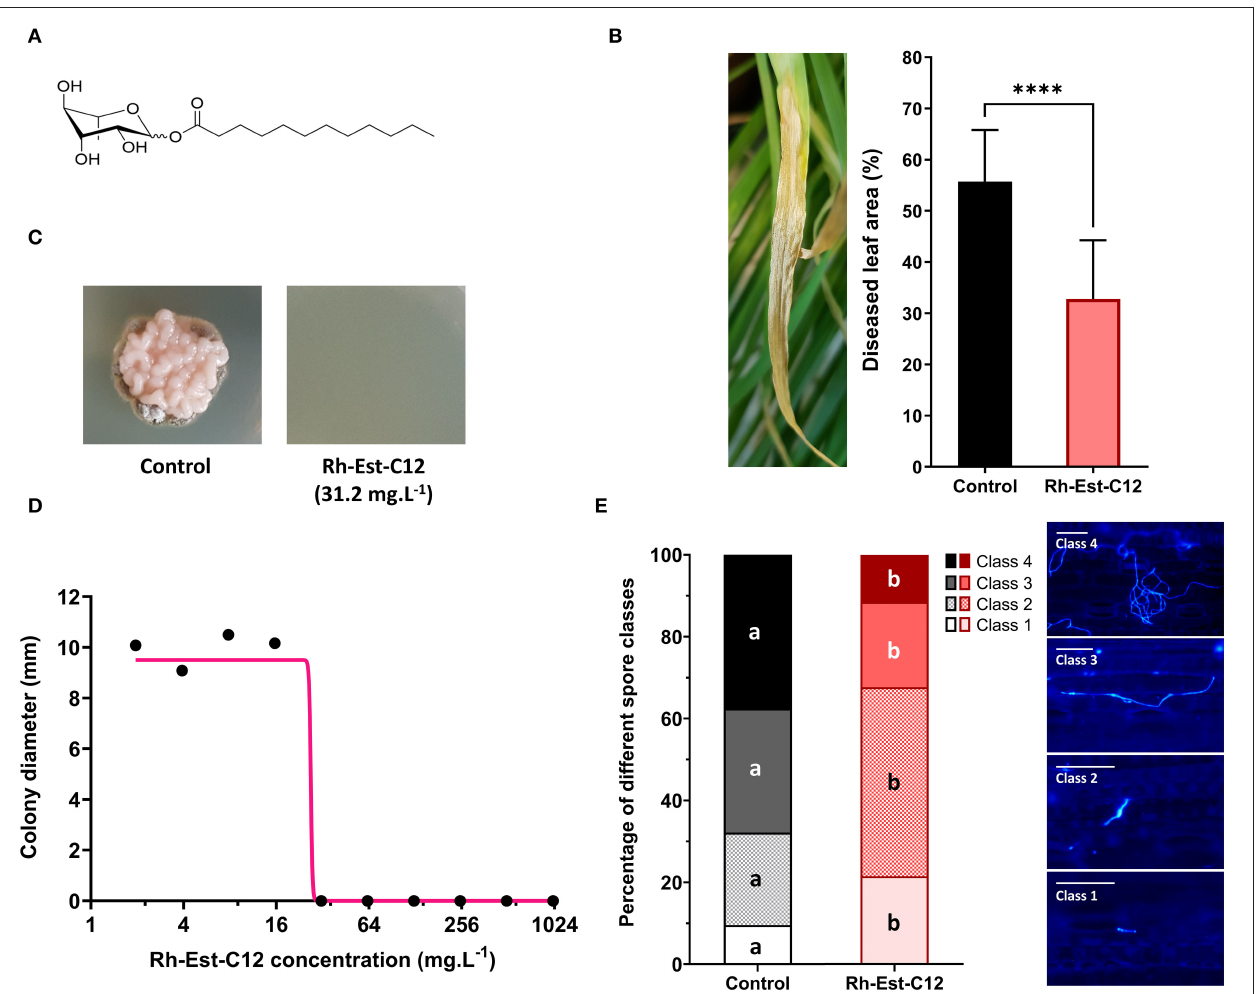
FIGURE 1 | Protective and antifungal effects of Rh-Est-C12 on wheat (Cv. Alixan) toward Zymoseptoria tritici (T02596 strain). (A) Molecular structure of the bioinspired synthetic rhamnolipid (RL) Rh-Est-C12 used in this study. The RL is composed of rhamnose linked to a C12-carbon chain with an ester bond. (B) Disease severity level of Septoria tritici blotch assessed 23 days post-treatment (D23) with Rh-Est-C12 at 500mg.L − 1 or a mock solution, i.e. , 21 days post-inoculation with the pathogen, by scoring the area of chlorosis and necrosis on wheat third leaves. Bars stand for standard-deviation ( n = 36). Data were analyzed by unpaired t -test ( P ≤ 0.05). A representative picture of disease symptoms on D23 in non-treated wheat is shown on the left of the Figure. (C) Pictures illustrating colonies in the following in vitro assay. (D) In vitro antifungal dose-response curve of Rh-Est-C12 against Z. tritici (T02596 strain). The direct antifungal activity of the rhamnolipid against the fungal pathogen was assessed by measuring perpendicular diameters of Z. tritici colonies after 10 days on PDA medium plates supplemented with different concentrations of the RL ( n = 6). Non-linear regression was designed using GraphPad Prism software version 9. (E) In planta epiphytic spore development state (class 1: non-germinated spore; class 2: germinated spore with small germ tube; class 3: germinated spore with developed germ tube; class 4: germinated spore with a strongly developed germ tube) was assessed using Calcofluor dye 5 days after treatment with Rh-Est-C12 at 500mg.L − 1 , i.e. , 3 days after inoculation. The class